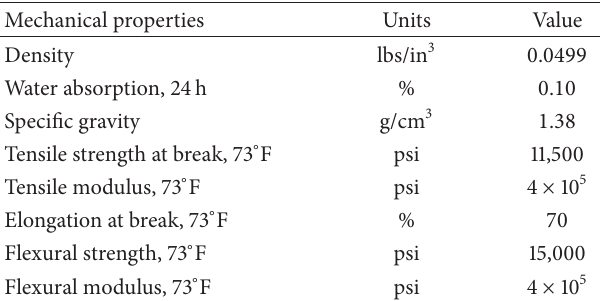
Table 4: Physical and mechanical properties of PET. Table 5: Compressive strength values of plain